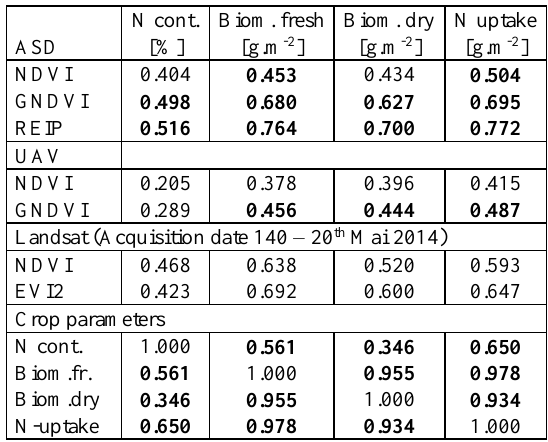
Table 2. Pearson correlation coefficients between vegetation indices from handheld spectrometer (ASD), UAV survey and Landsat OLI images (acquisition day marked) and crop parameters for BBCH 59. Bold values are statistically significant at 95 % level.